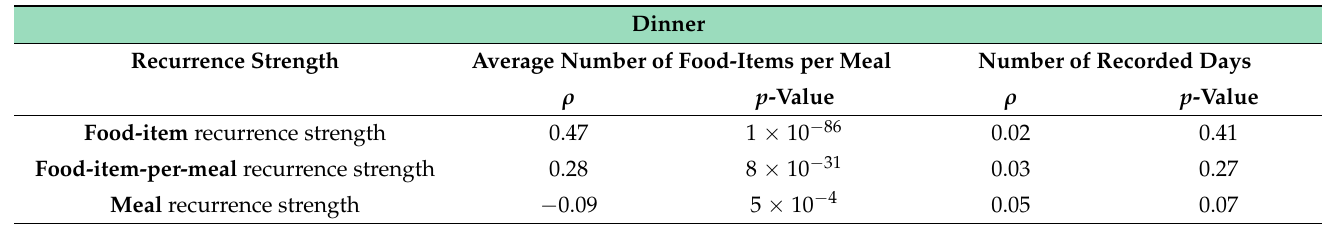
Table 6. Pearson’s correlation coefficient ρ and significance indicated by the p -value between recur- rence strength tuple and other variables for dinner